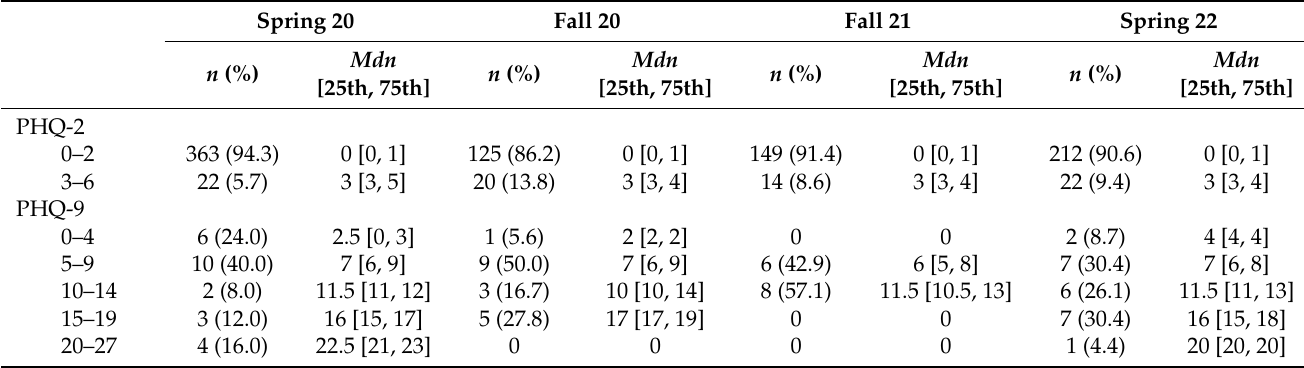
Table 2. PHQ screening results distribution by score category.